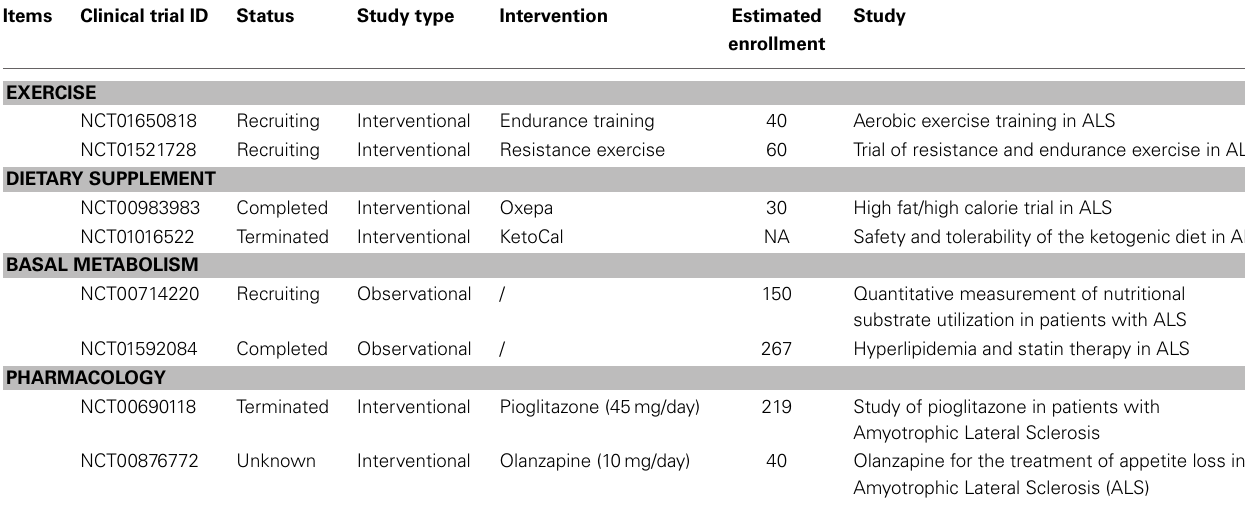
Table 4 | Ongoing clinical trials in